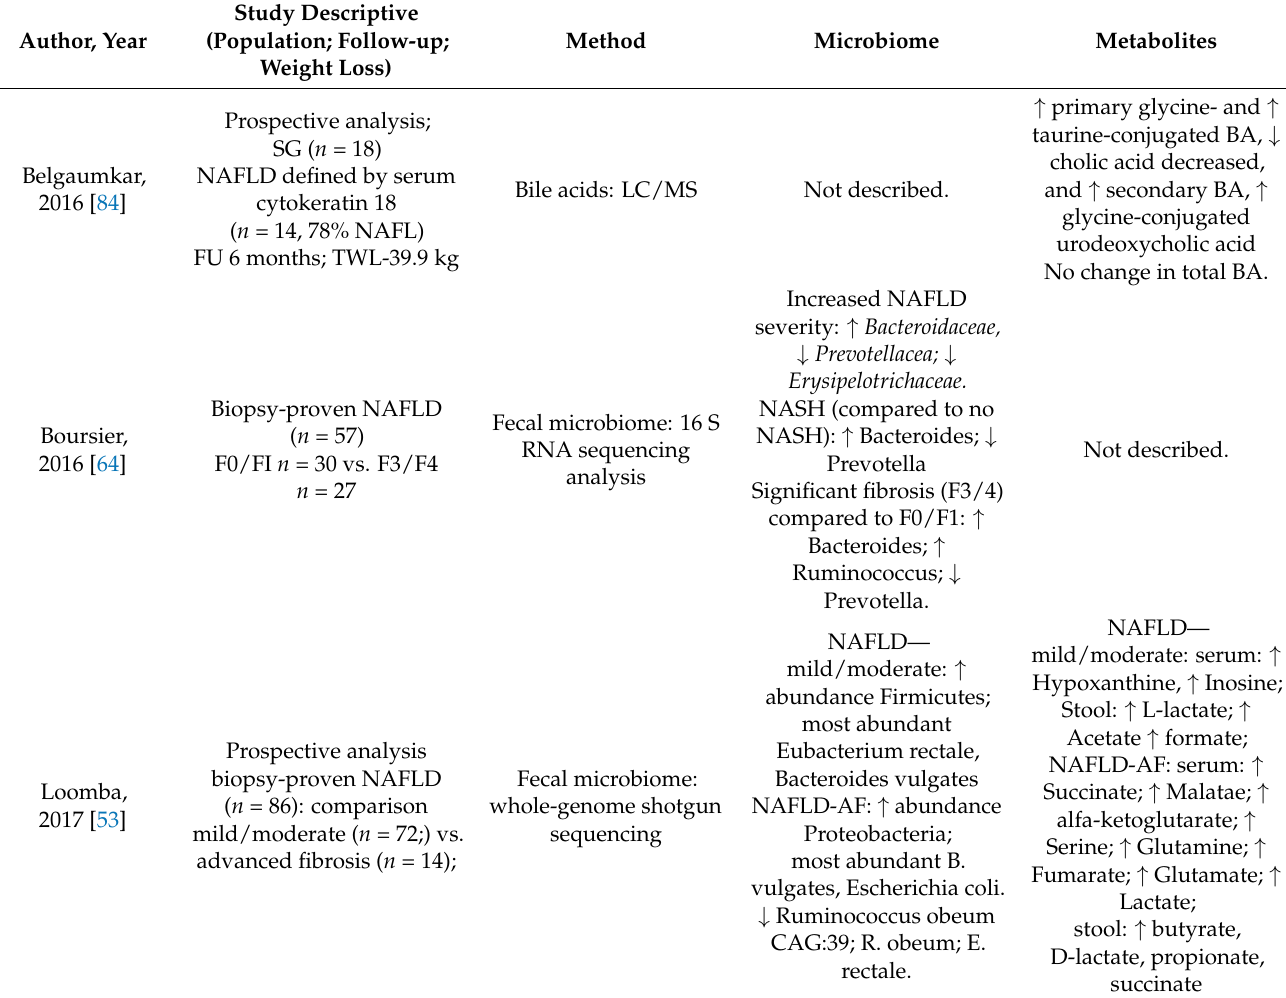
Table 1. NAFLD, gut microbiome and